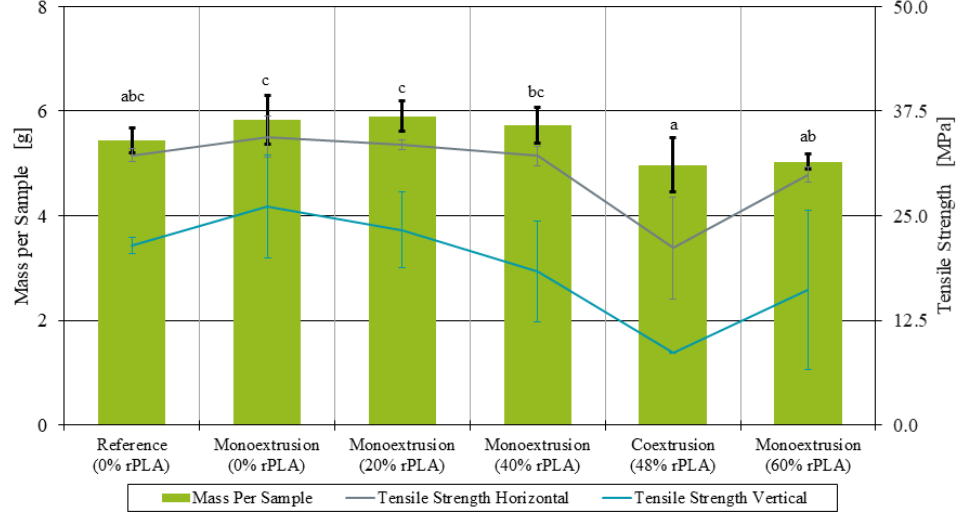
Figure 9. Average mass of tensile testing samples printed in both horizontal and vertical